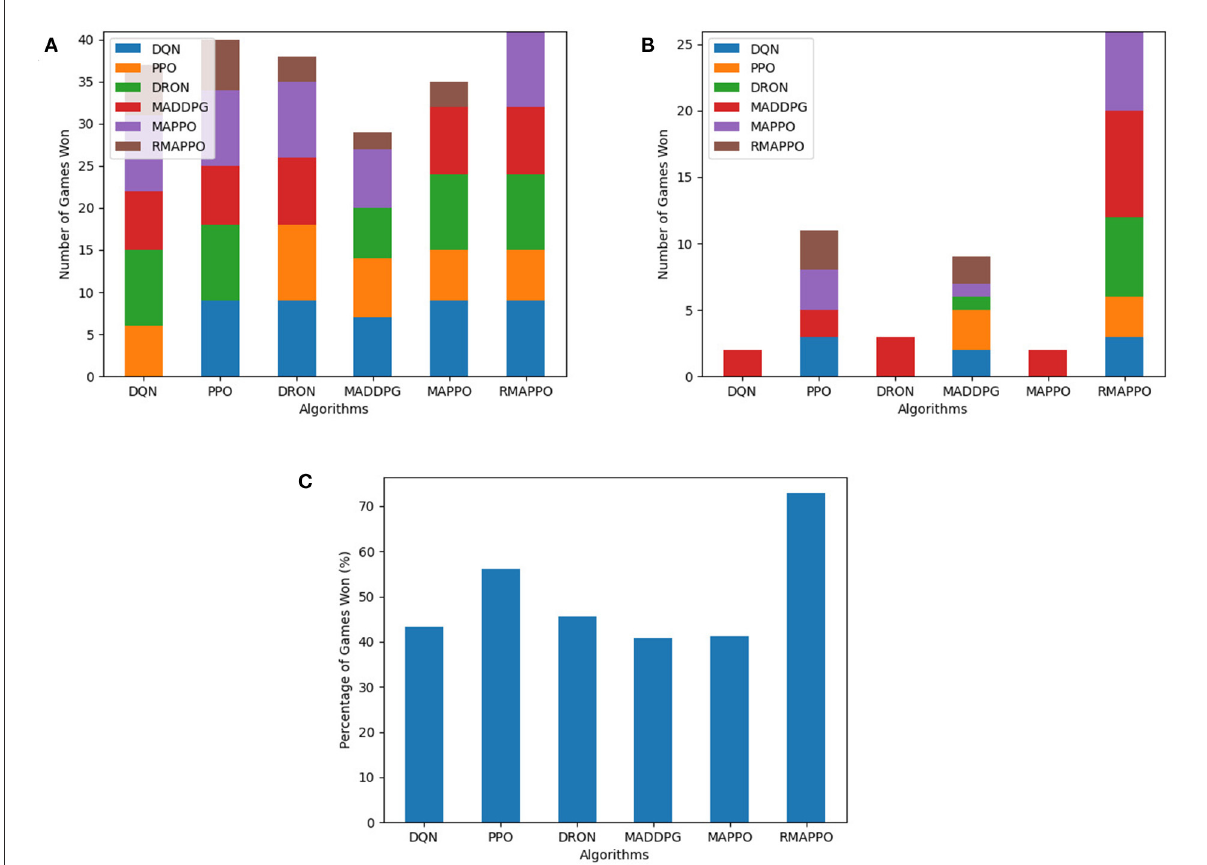
FIGURE9 Performance of various algorithms when playing against other algorithms in Pong without agent indicators across 3 seeds. (A) Shows the number of games won as the first player, (B) shows the number of games won as the second player, (C) shows the overall win rate